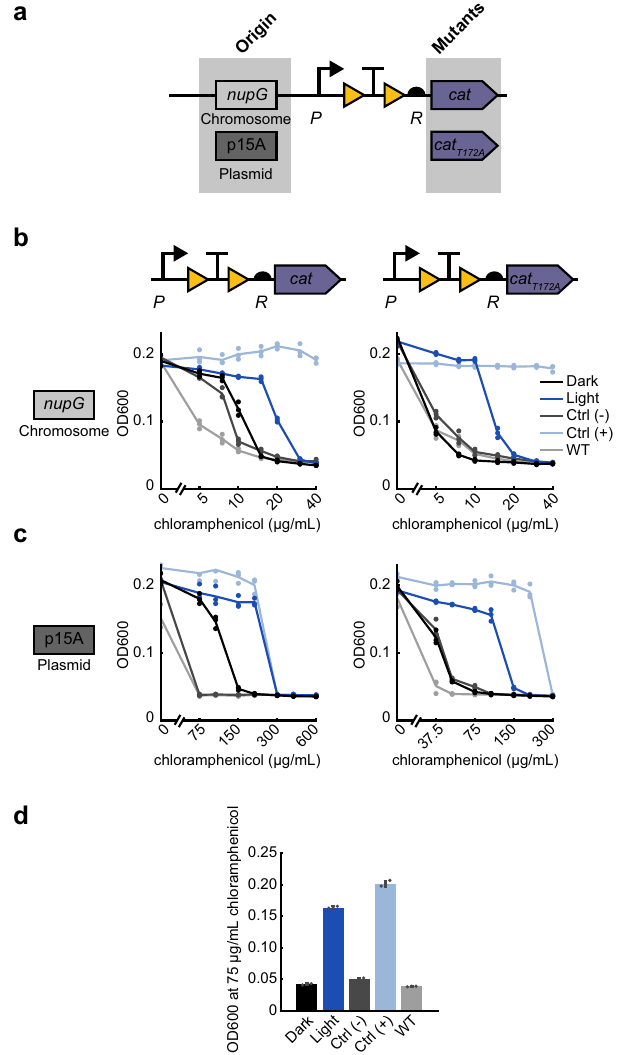
Fig. 3 | Tuning optogenetic activation of chloramphenicol resistance from OptoCre- cat through decreased enzymatic activity. a Resistance given by the chloramphenicolresistancegene cat canbeloweredbyusingthe cat T172A varianton a chromosomal or plasmid origin. b MIC curves of OptoCre- cat activation cassette with the native enzyme cat or weakened enzyme cat T172A on the chromosome ( n =3). c MIC curves of the cat and cat T172A activation cassettes on a plasmid with the p15A origin ( n =3). d Optimal activation conditions, using cat T172A with pro- moter P and RBS R on a plasmid origin at 75 µ g/mL chloramphenicol. Growth is quanti fi ed by OD600 after 18h. Error bars show standard deviation around the mean ( n =3 biological